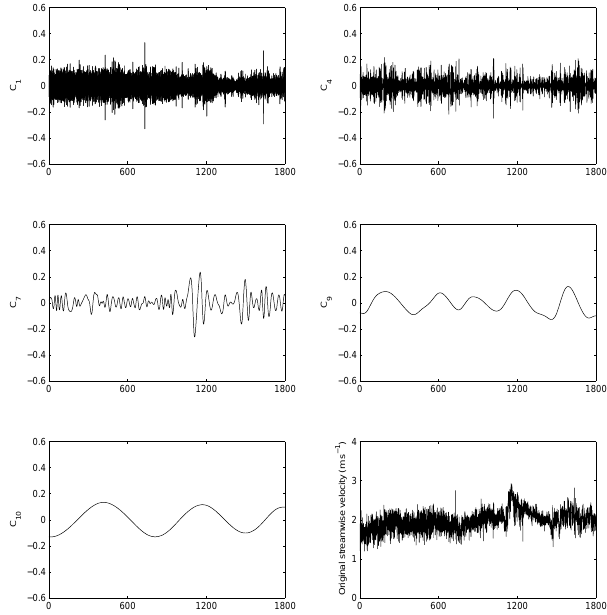
Fig. 2. Example of empirical mode decomposition and intrin- sic mode functions obtained by sifting original timeseries data de- scribed from Eqs. (1 to 6) from the 20Hz sampled longitudinal wind